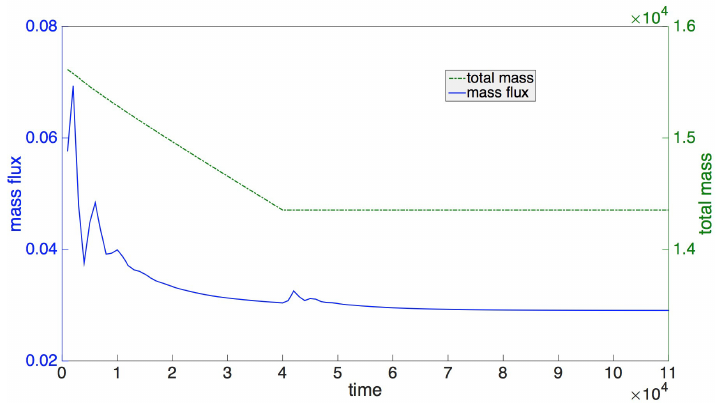
Figure 4. Evolution of the total mass in the pore and the evaporating mass flux at the outlet: the blue solid line is mass flux; the green dotted dash line is the total mass; the implementation of ghost layer boundary condition starts from time 4 × 10 4